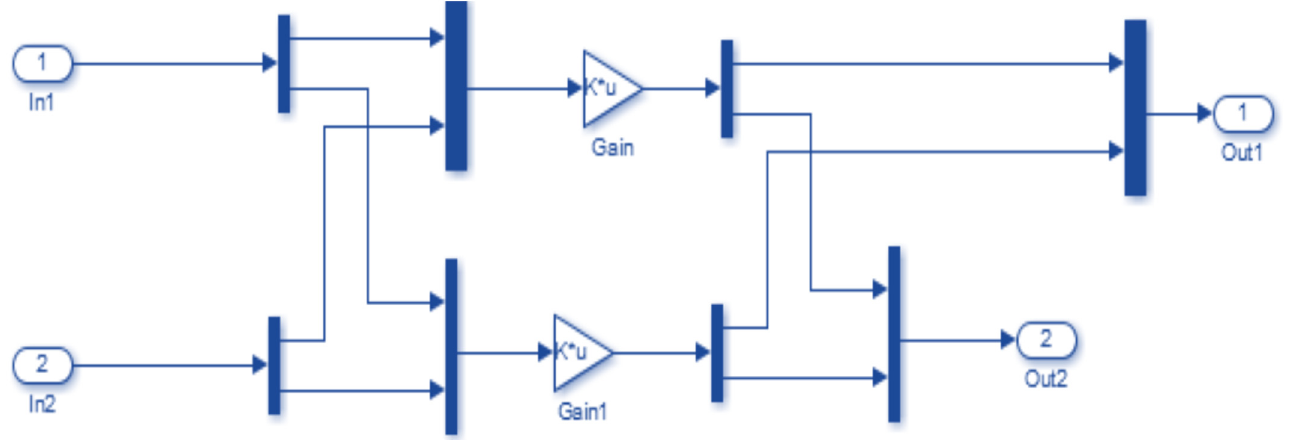
Figure 6. Flux current relation.